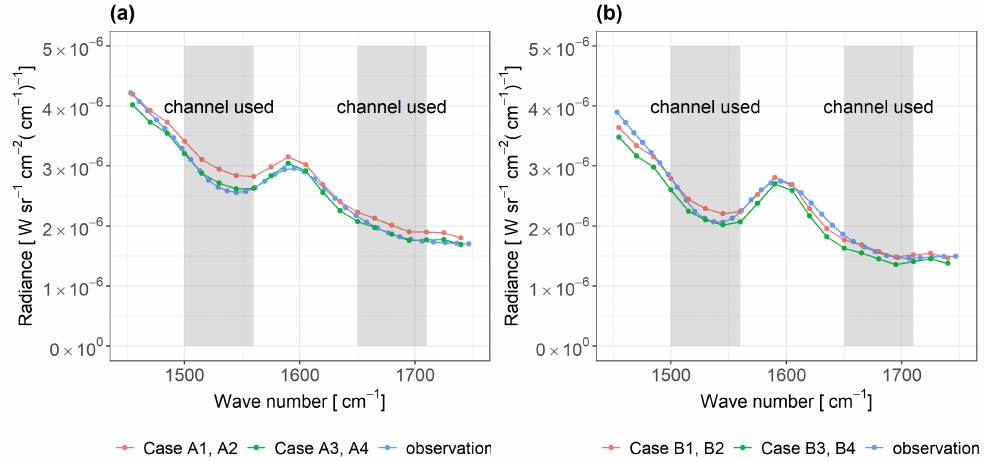
Figure 7. Simulated spectra (Cases A1–A4, B1–B4) and observed spectra. We used the mean of the prior information as the air temperature distribution of the forward-model-simulated